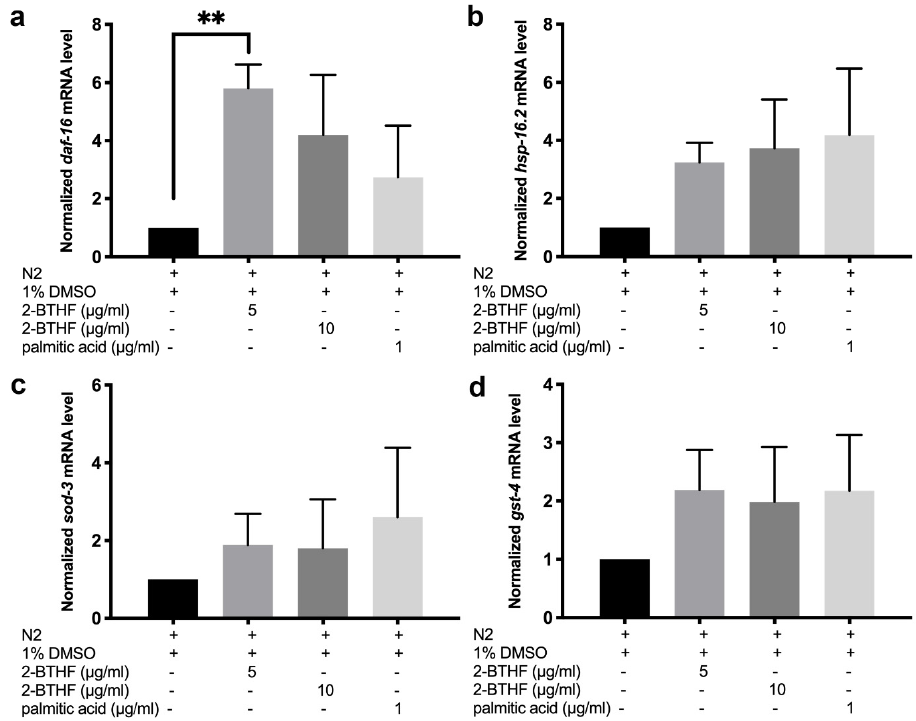
Figure 9. The mRNA levels of daf-16 , hsp-16.2 , sod-3 , and gst-4 in N2 worms treated with 1% DMSO, 5 μ g/mL 2-BTHF, 10 μ g/mL 2-BTHF, and 1 μ g/mL palmitic acid of H. scabra were quantified using qRT-PCR. The normalized mRNA levels of daf-16 ( a ), hsp-16.2 ( b ), sod-3 ( c ), and gst-4 ( d ) are shown. The results of gene expression were analyzed by one-way ANOVA following Bonferroni’s method, ** p < 0.01.